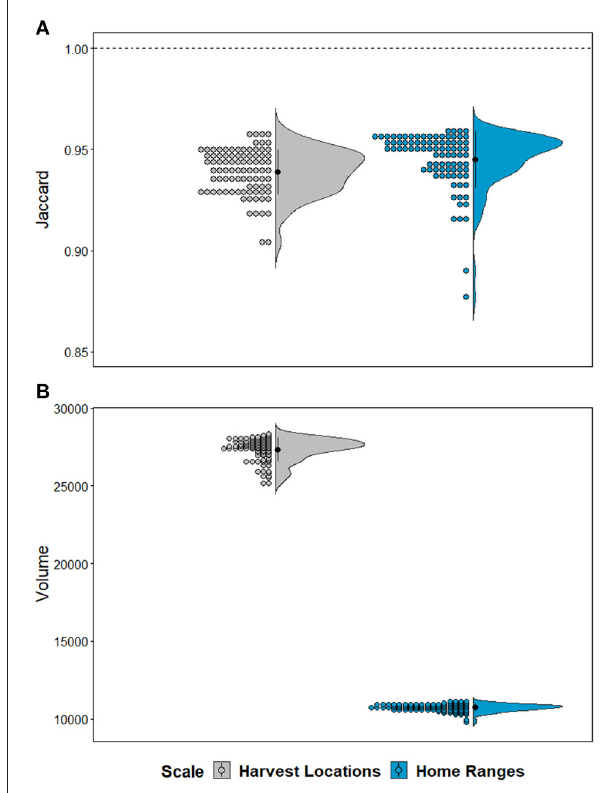
FIGURE 5 | Hypervolume variation and characteristics by scale. (A) Plots show Jaccard’s similarity index between hypervolume sets of the full CWD-positive dataset ( n = 88) and those created from iteratively removing one occurrence record (leave-one-out). Note that the models never reach a Jaccard similarity index values at 1 denoted with dashed horizontal line, which indicates a failure to reach complete overlap and identical position and size in environmental space. (B ) Half-violin plots and raw data distribution represent volumes extracted from hypervolumes created from leave-one-out iterations. Colors represent the scale for whether models were delineated from data at Harvest Locations (gray) or Home Ranges (blue). Note that hypervolumes from home ranges generally occupied smaller volumes in environmental space despite equal sample